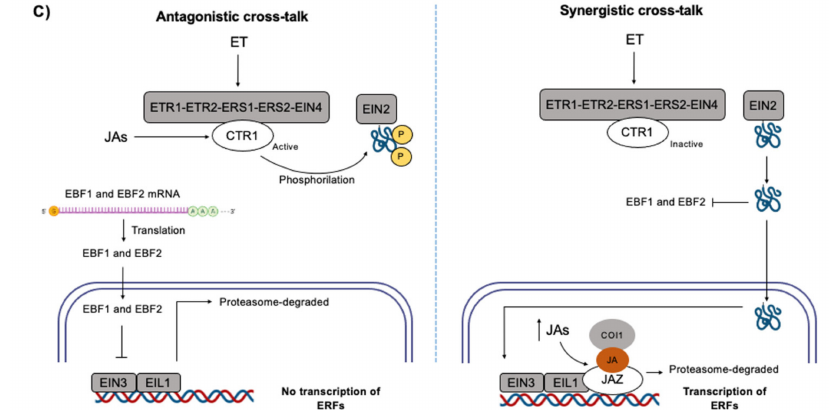
Figure 1. Ethylene and JAs signaling. ( A ) Ethylene signaling. In the presence of ethylene, receptors ETR1, ETR2, ERS1, ERS2, and EIN4 perceive ethylene and deactivate CTR1. EIN2-CEND is cleaved and released from EIN2 and inhibits translation of inhibitors EBF1 and EBF2. EIN2-CEND translo- cates to the nucleus and induces EIN3/EIL1, which in turn activates ERFs, and, finally, ERFs induce transcription of ethylene responsive genes. ( B ) JAs signaling. When JA-Ile accumulates in the cytosol, it enters the nucleus via JAT1. Then, it binds to protein COI1 from the SCF COI1 complex, and, later, they recruit JAZ to form a temporary complex to promote degradation of JAZ. Upon this degradation, MYC2 that is interacting with MED25 is liberated and induces transcription of JA-responsive genes. ( C ) Proposed signaling pathway for ethylene and JAs cross-talk under abiotic stress. Two types of cross-talk have been described for ethylene and JAs. In an antagonistic cross-talk, JAs reactivate CTR1 after ET perception in the cytosol. CTR1 phosphorylates EIN2-CEND, inactivating it. In this manner, translation of EBF1 and EBF2 mRNA takes place and EBF1 and EBF2 enter the